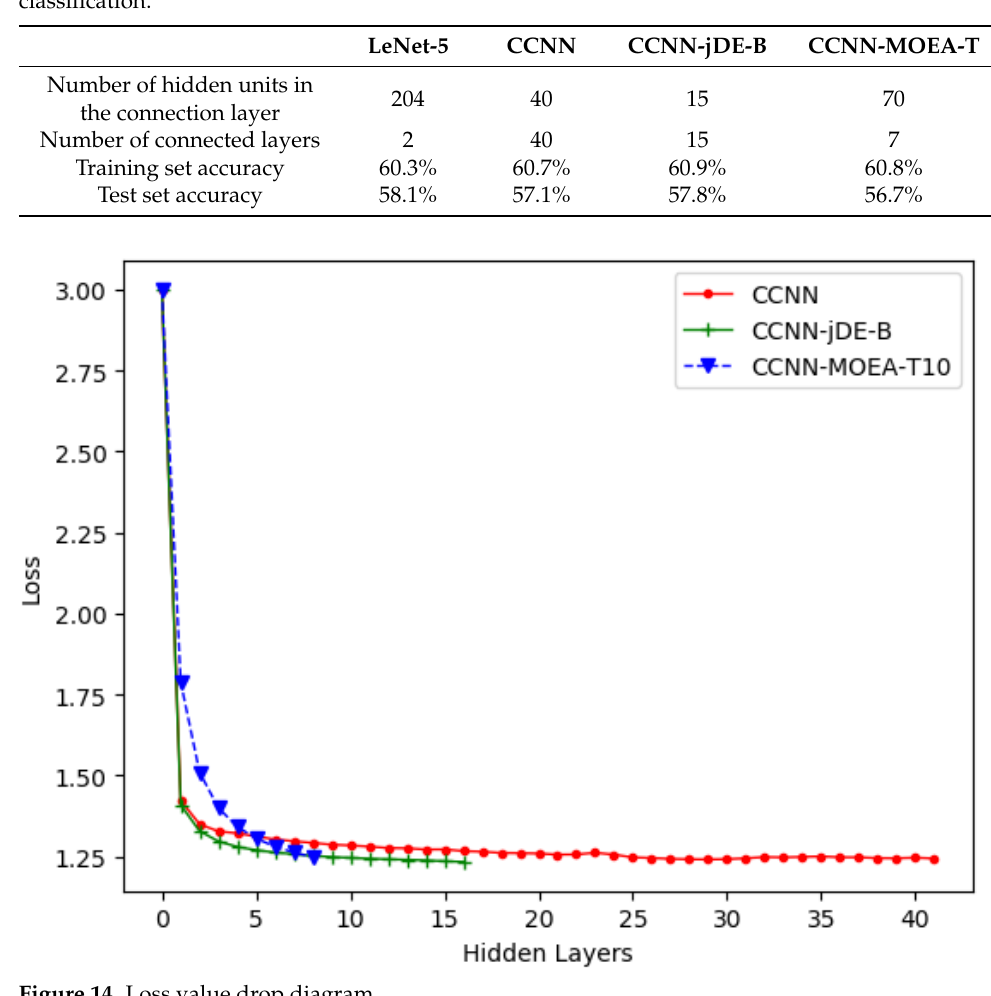
Figure 14. Loss value drop diagram.